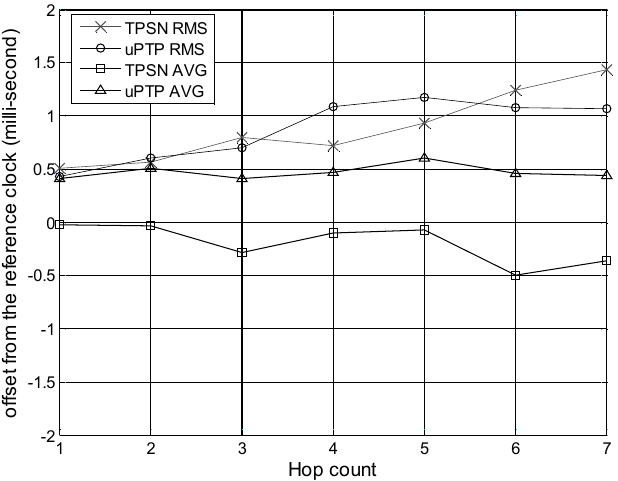
Figure 9. Accuracy and precision vs . hop